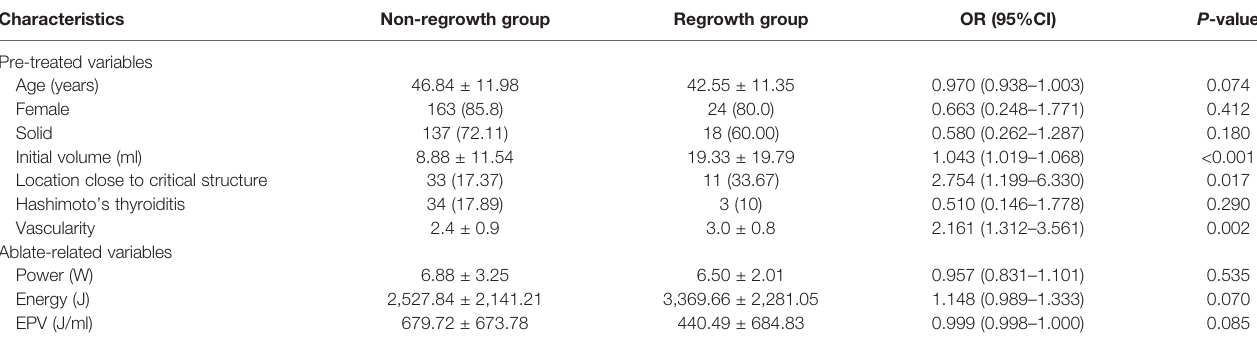
TABLE 3 | The comparison between the non-regrowth and regrowth groups.